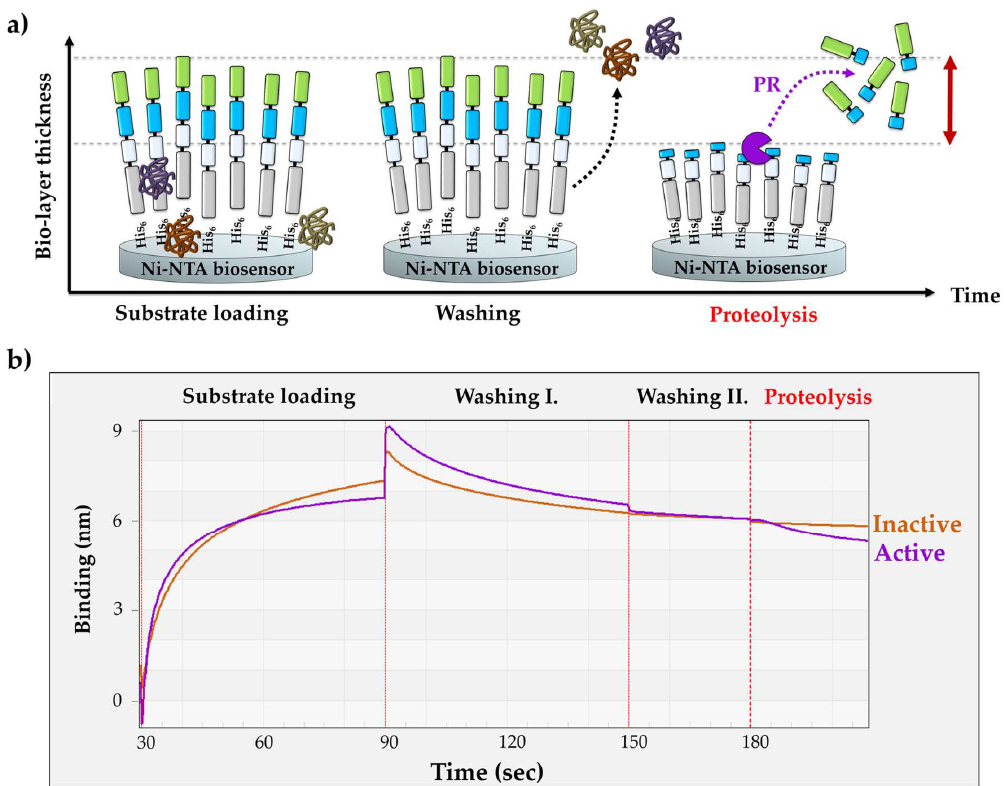
Figure 2. Principle of the BLI-based protease assay. ( a ) Schematic representation of the biosensors during the assay. ( b ) A representative sensogram shows the steps of the assay procedure. After setting up the baseline using Ni-NTA biosensors in tube-mode, the RFP substrates are loaded onto the sensors in drop-mode until saturation. Loading is subsequently followed by tube- and drop-mode washing steps. Cleavage reactions were performed using a catalytically active (HIV-1 PR wt , purple) and inactive HIV-1 PR (HIV-1 PR ∆ N ∆ C , orange) enzyme. The same Ni-NTA biosensor was used for the parallel experiments, and the sensor was regenerated between the measurements at low pH (based on manufacturer’s